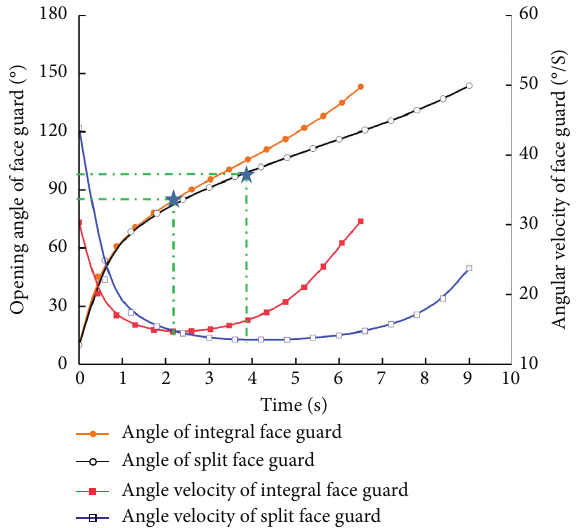
Figure 6: Comparison of the motion characteristics between the two kinds of face guards.